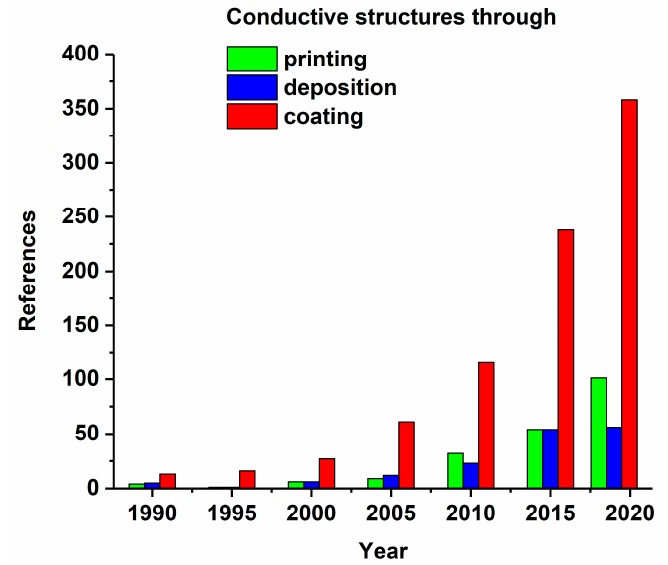
Figure 6. Research activity in coating, deposition, and printing processes to manufacture conductive structure in textiles.